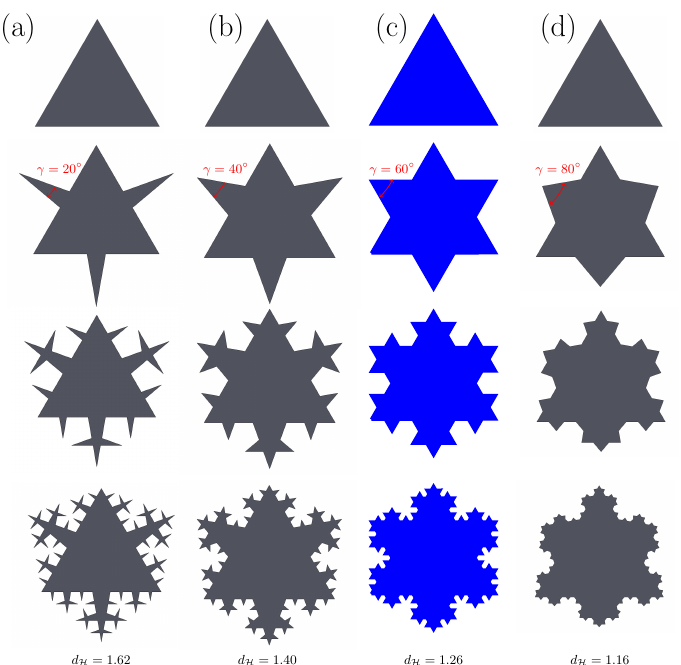
Figure 2. Fractal cross section of beams for the first four iterations of the Koch snowflake. The side of the equilateral triangle is 20 mm, with an indentation angle of: ( a ) γ = 20 ◦ , ( b ) γ = 40 ◦ , ( c ) γ = 60 ◦ , and ( d ) γ = 80 ◦